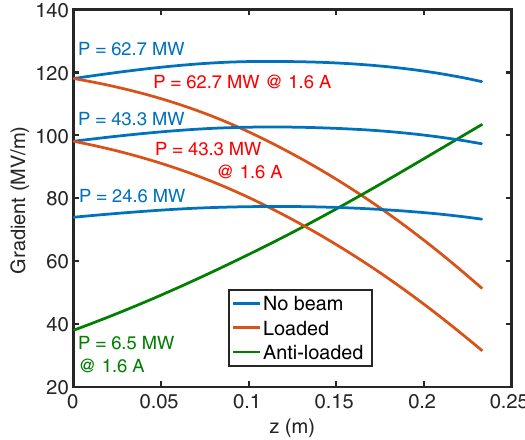
FIG. 3. Longitudinal accelerating profile for the structure under test: unloaded (blue lines) at 62.7, 43.3, and 24.6 MW input power, loaded (red lines) in the 3 TeV CLIC design conditions for with 1.6 A of beam current at 43.3 MW of input power, and anti- loaded (green line) with the same current and 6.5 MW of input power. The gradient profile from beam ¼ loading without rf is given by the difference of the blue and red curve at the same input power.